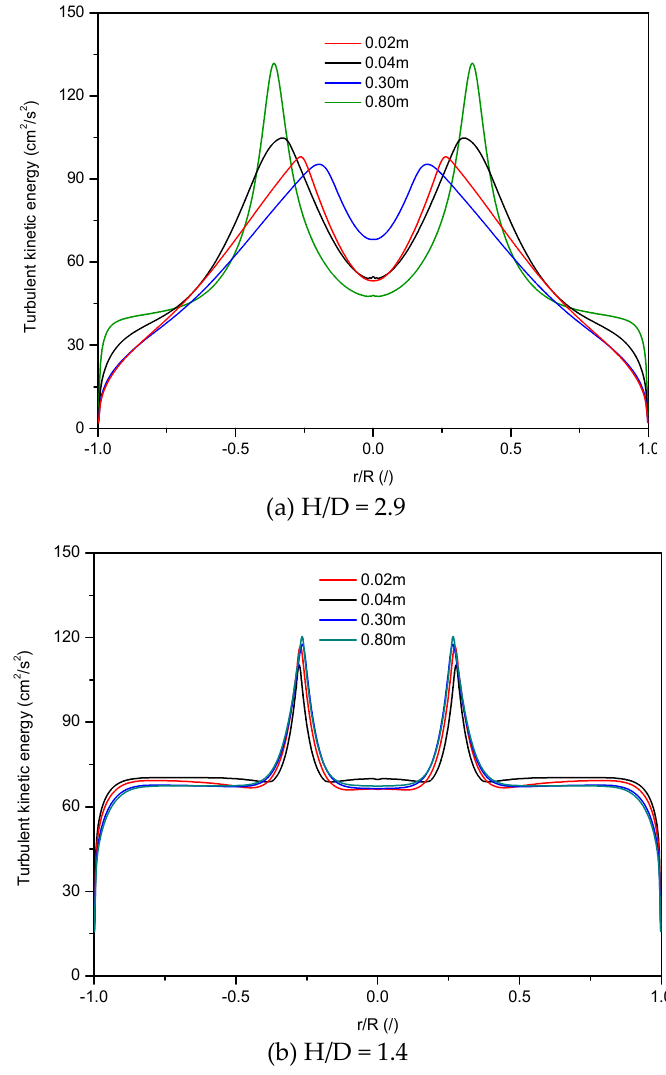
Figure 6. Distributions of turbulent kinetic energy of bubble phases using two jetting holes (rjet/R = ±0.36), H/D = 2.9 and H/D = 1.4.